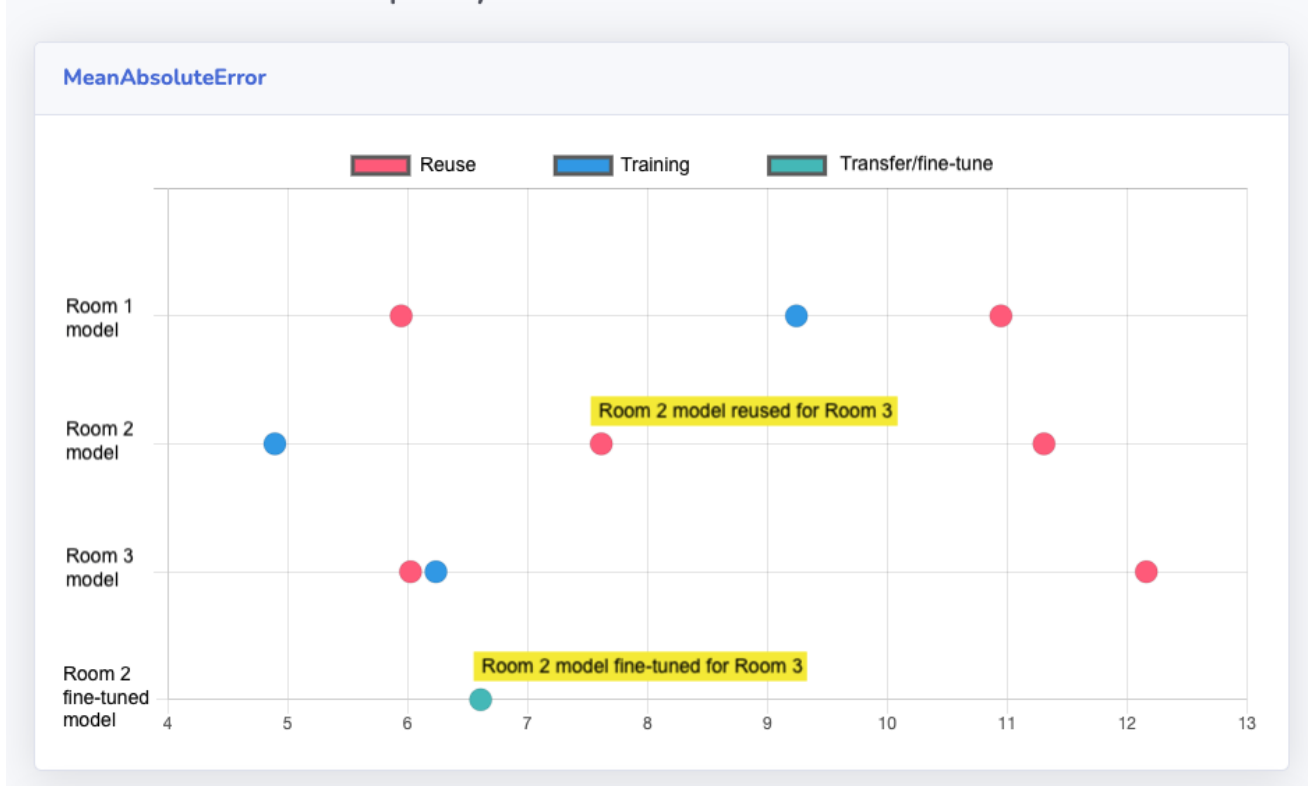
Figure 8. Snapshot of inter-space learning prototype for evaluation of occupancy prediction models. On the y-axis the available models for fulfilling the occupancy prediction are shown and the x-axis represents the Mean Absolute Error (MAE) for comparing the performance of those